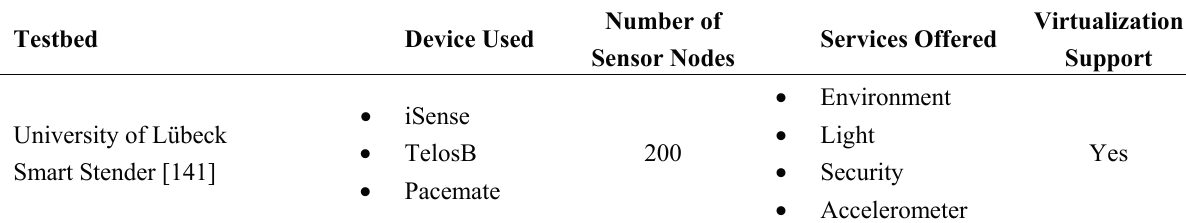
Table 3. Testbeds for evaluation of middleware